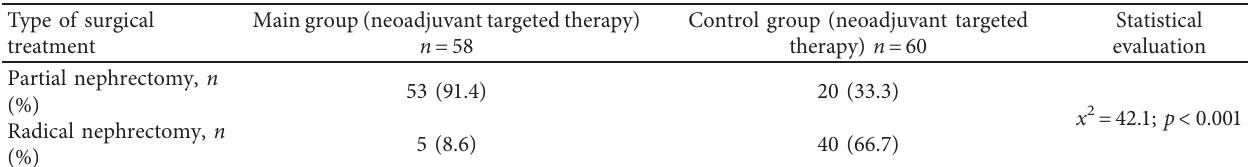
Figure 2: Percentage of regression of localised RCC after 2 cycles of neoadjuvant TTaccording to the results of spiral CTwith bolus contrast enhancement, n � 58. Stable disease according to RECIST1.1 (up to 30% regression) is shown as yellow, and partial regression according to RECIST 1.1 (30% regression to 100%), green. RCC, renal cell carcinoma; CT, computed tomography; TT, targeted therapy; RECIST, Response Evaluation Criteria in Solid Tumours. Table 2: Distribution of surgical interventions in groups, n � 118.